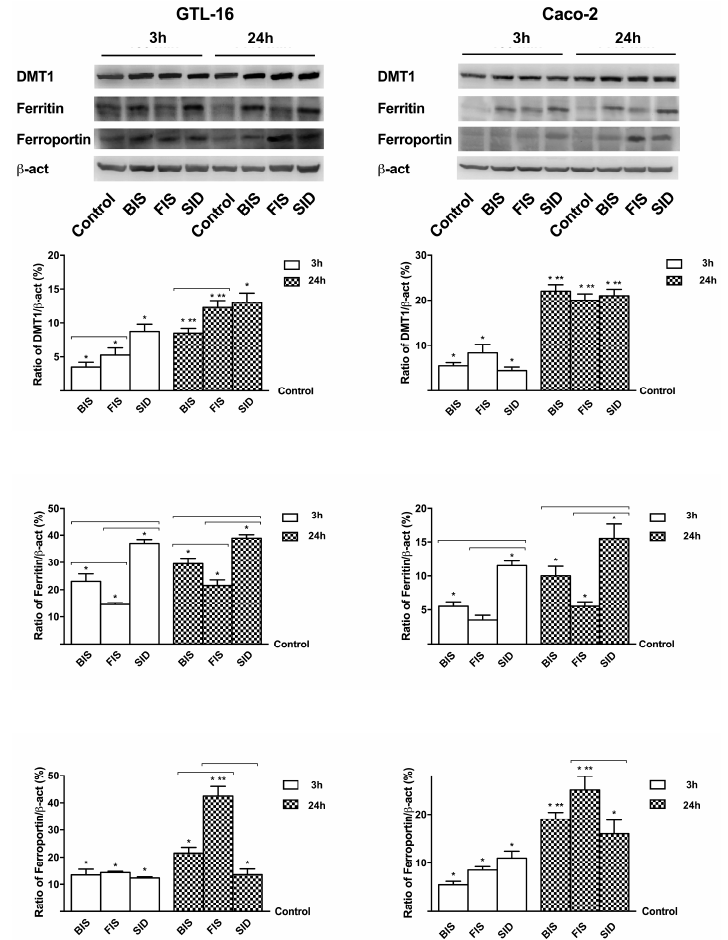
Figure 5. Western blot (upper) and densitometric analysis (down) of DMT1, ferritin light chain and ferroportin expressed on GTL-16 and Caco-2 cells treated with different iron formulations at 3 h and 24 h. The images are an example of four independent experiments for each cell type. The results obtained after normalization through β -act and then through control values are expressed as means ± SD of four independent experiments for each cell types. * p < 0.05 vs. control; ** p < 0.05 vs. correspondent column at different times; bars p < 0.05 among different treatments at the same